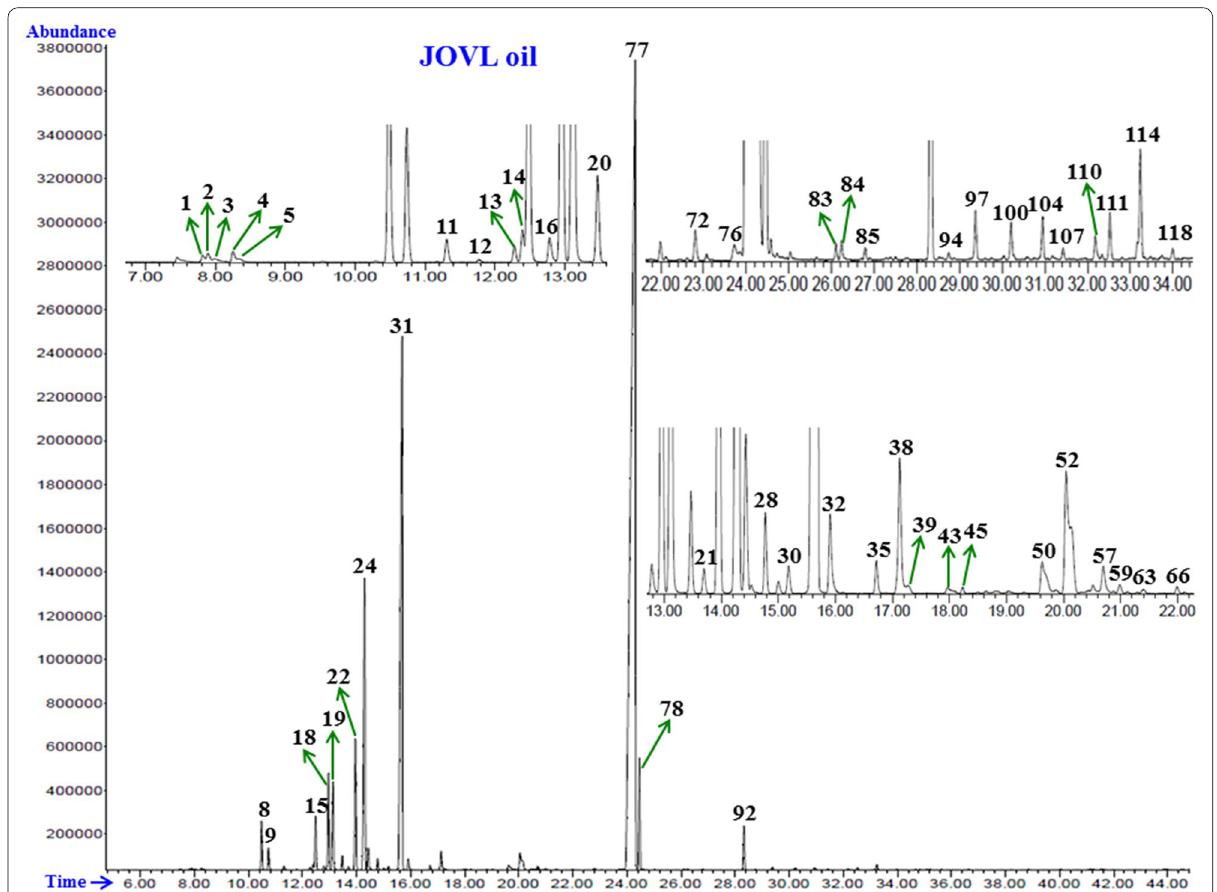
Fig. 2 GC–FID chromatogram of essential oil from stems of Jordanian O. vulgare L. obtained using an HP-5MS column. The characterized peaks